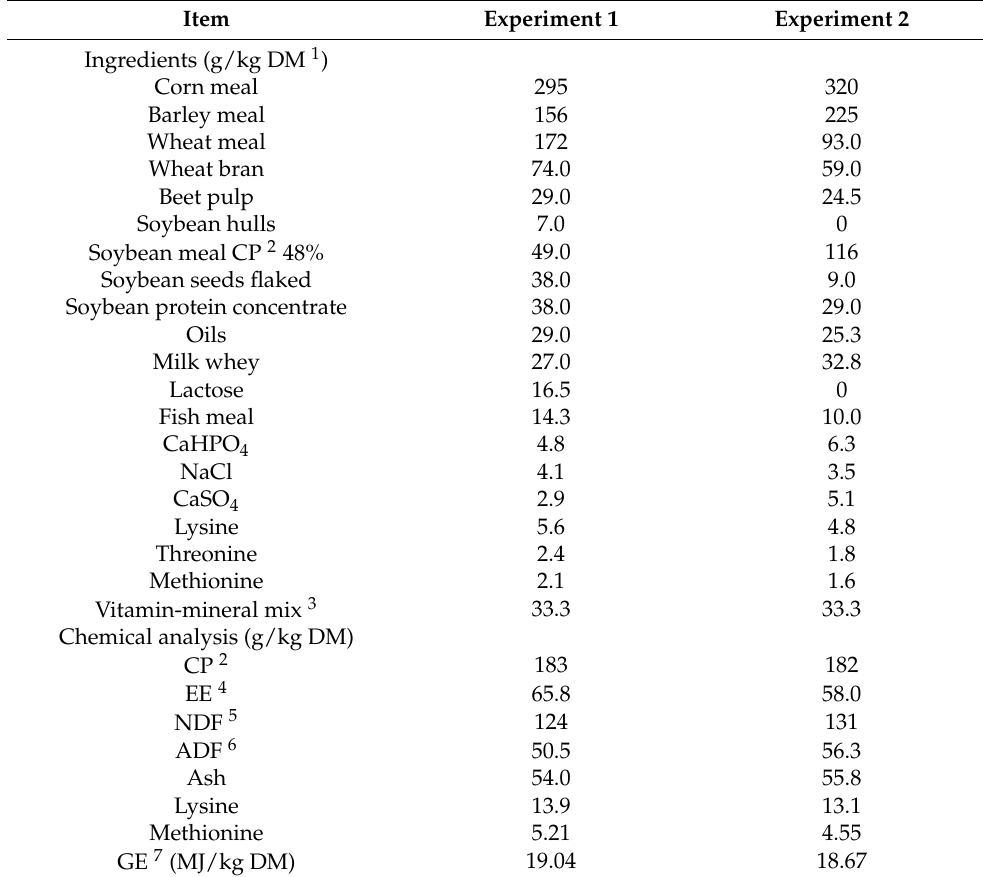
Table 1. Composition and chemical analysis of the control diets administered in the experiment 1 (post-weaning trial) and in the experiment 2 (digestibility